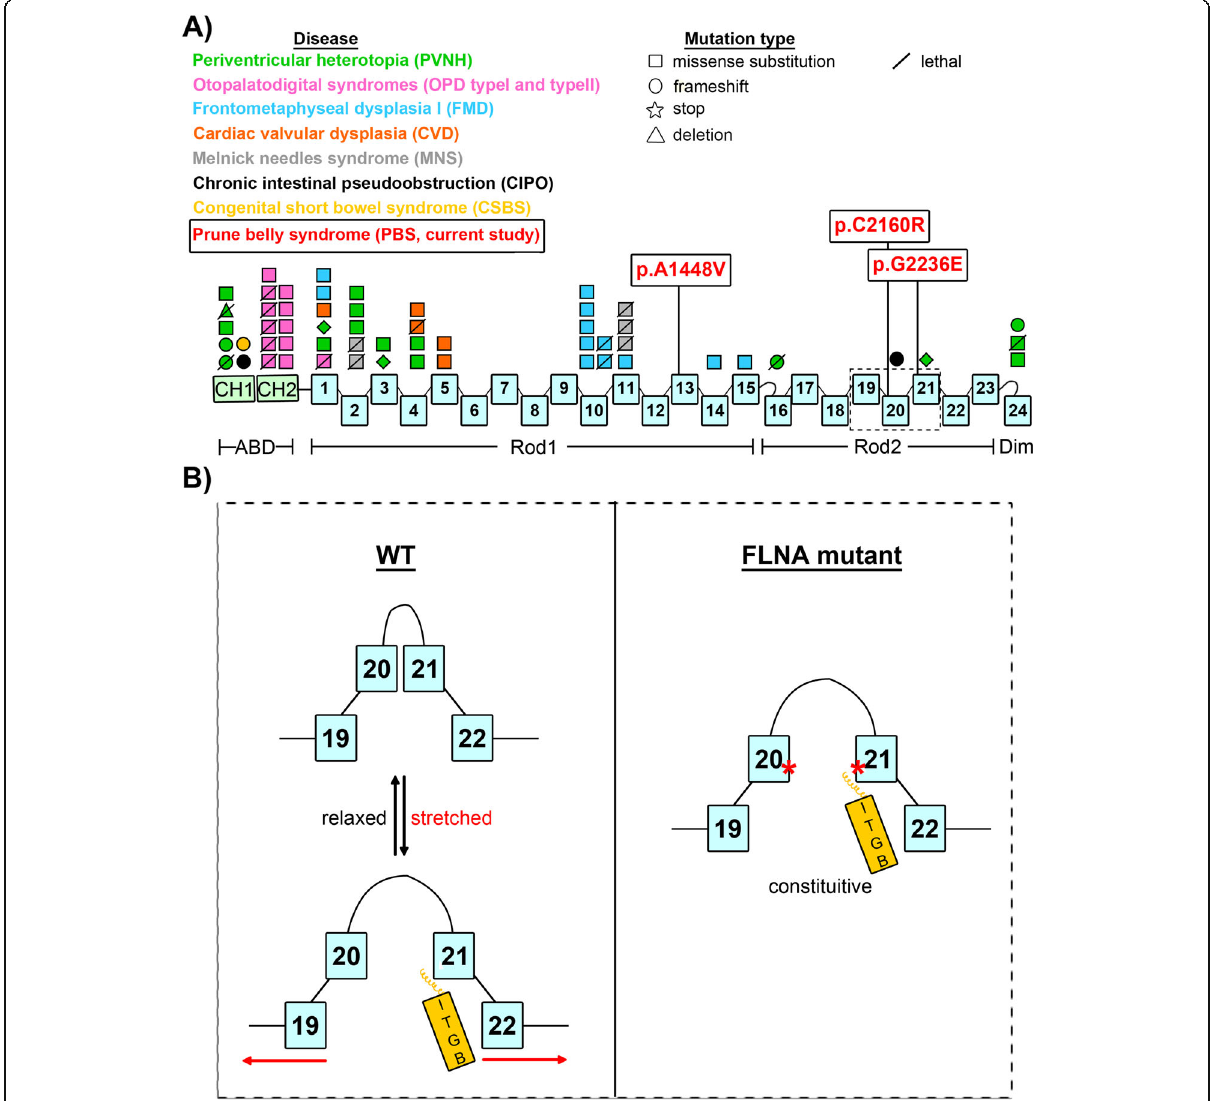
Fig. 5 Human Disease Causing Mutations in FLNA in Surviving and Non-surviving Males. a FLNA disease-causing mutations cluster in ‘ hot spots. ’ PVNH mutations are largely found in the actin binding domain (ABD) while OPD spectrum disorders (including OPD, FMD and MNS) cluster in IgFLNA10. We identified 3 novel PBS variants: A1448V in IgFLNA13 (Rod 1), C2160R in IgFLNA20 and G2236E in IgFLNA21 (Rod 2). b Model for FLNA interaction with integrins. In a relaxed state, there is an auto-inhibitory interaction between Ig20 – 21 that masks the integrin binding site on Ig21. Normally, mechanical stretching can cause exposure of the integrin binding site on Ig21. Mutations in Ig19 – 21 result in loss of FLNA function as a stretch sensor and disruption of the auto-inhibitory interaction between Ig20 – 21 causing constitutive exposure of the